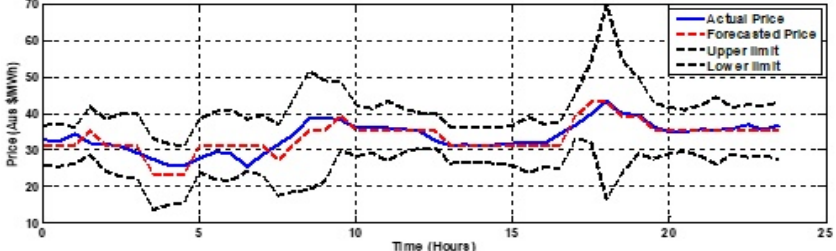
Figure 17. Winter weekend plot of Saturday (11 July 2015) without selected features with a MAPE of 8.60.